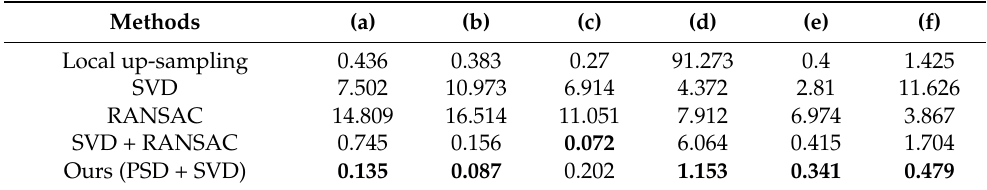
Figure 10. Comparison of absolute accuracy of simulation experiments. Table 2. Comparison of absolute accuracy of simulation experiments, where the unit is the pixel, and the bold font is the minimum error value among the five methods.